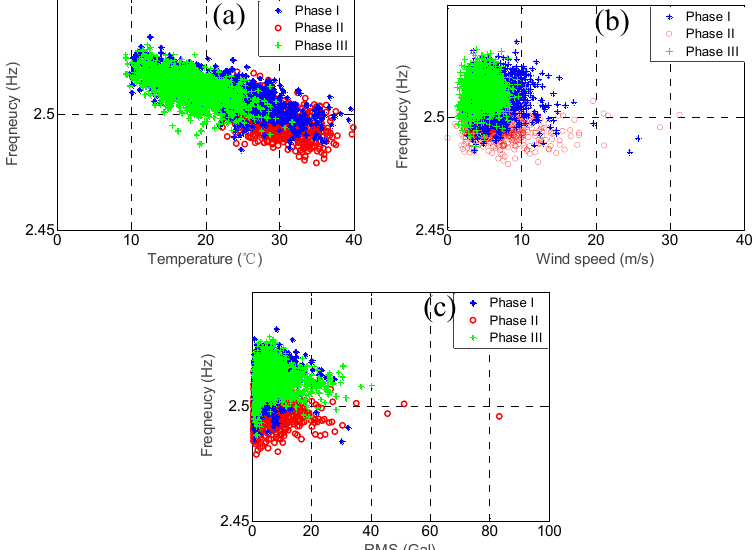
Figure 15. The relationship between the 3rd modal frequency (2.51 Hz) and ( a ) temperature; ( b ) wind speed; and ( c ) RMS acceleration.